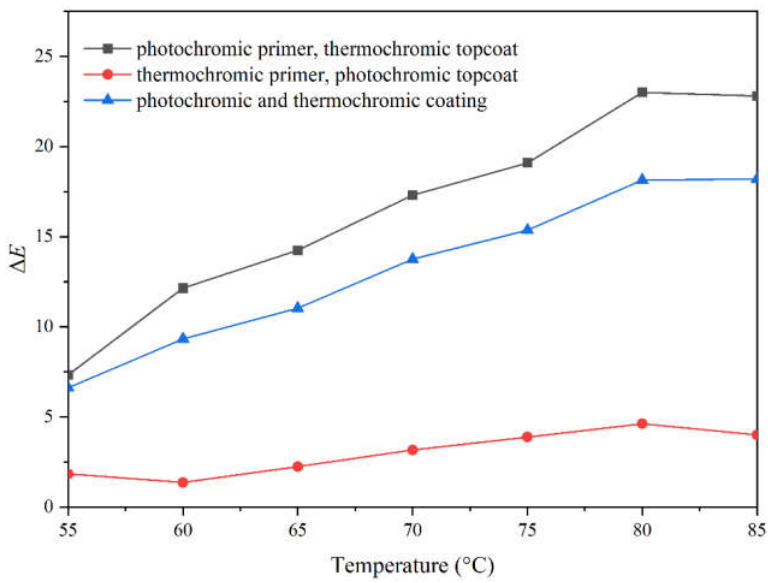
Figure 5. Chromatic difference of the film under different finishing sequences during the heating process.